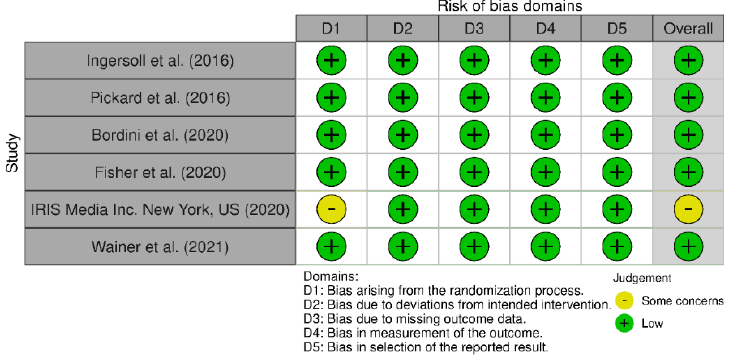
Figure 2. Risk of bias assessment [12–17].